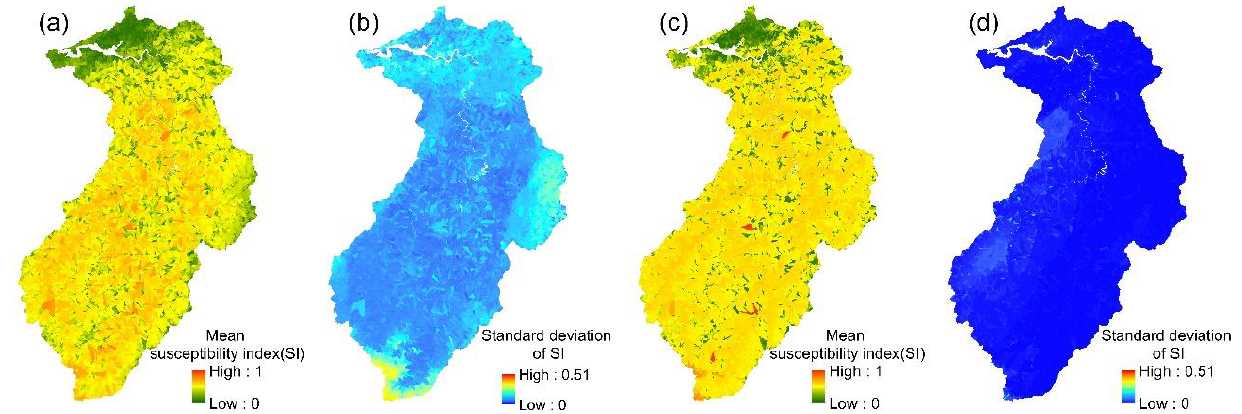
Figure 5. RF models: ( a , b ) the mean susceptibility index and standard deviation of 24 event-based models; ( c , d ) the mean susceptibility index and standard deviation of the multi-year model.